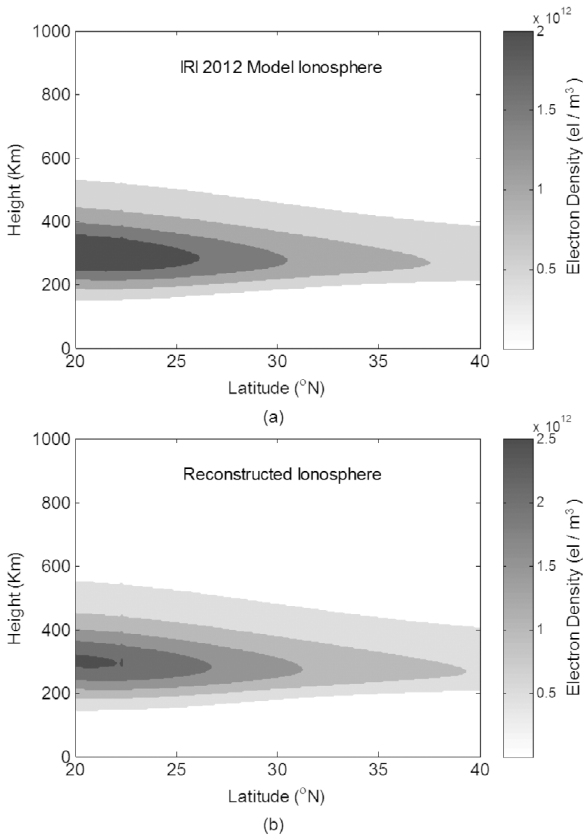
Figure 1. Electron density (10 12 m -3 ) distribution of the ionosphere at 10 UT on September 20, 2011, for: (a) IRI 2012 model (b) recon- struction using